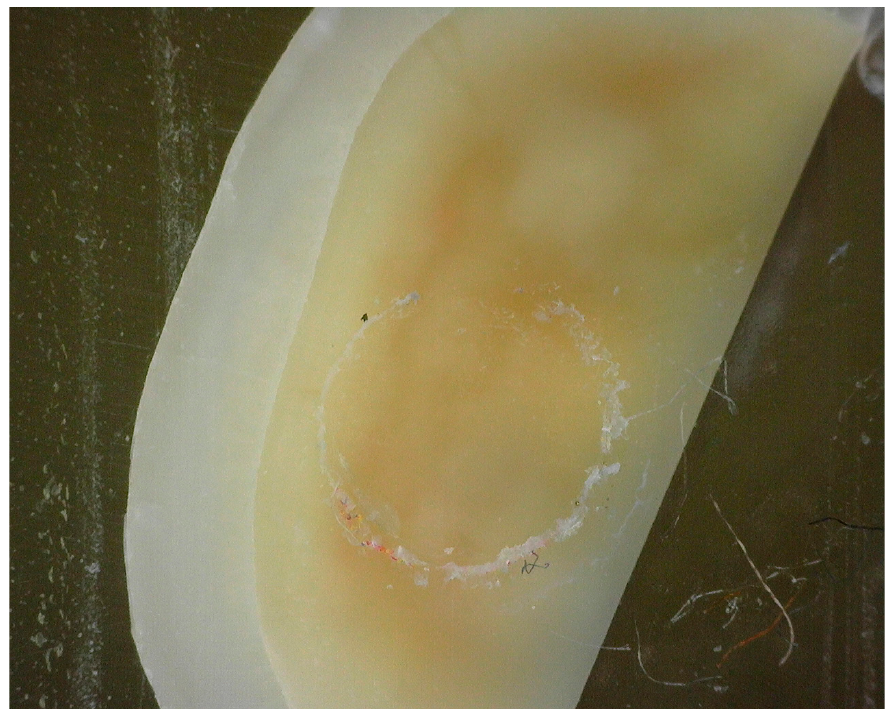
Figure 4. Adhesive fracture between the composite sample and dentin surface.